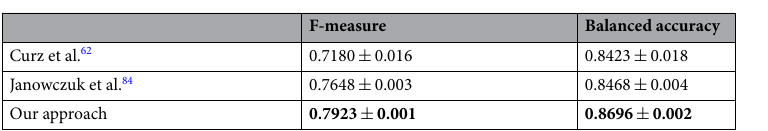
Table 4. Performance comparison between our network and other approaches. Significant values are in